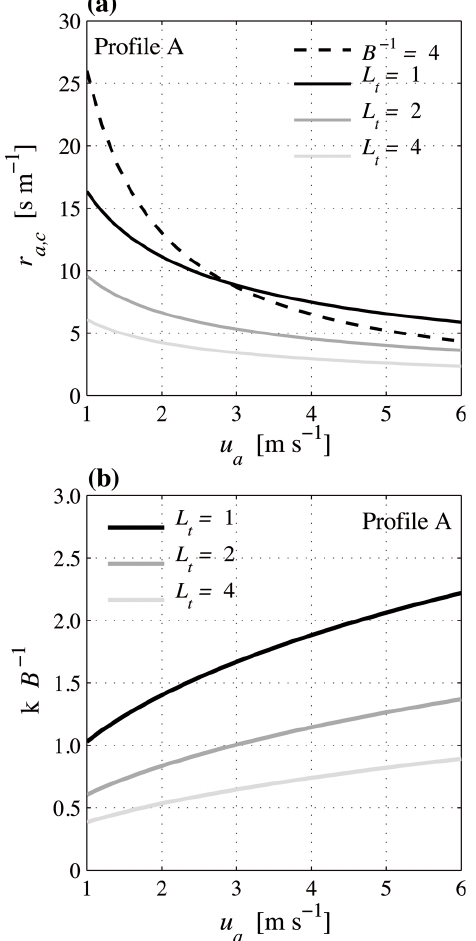
Fig. 5. (a) The additional aerodynamic resistance ( r a,c ) given by Eq. (20) is plotted as a function of wind speed at reference height ( u a ) for different LAI ( L t ) and compared with the rough estimate based on B − 1 = 4 (leaf area profile A); (b) the bulk parameter kB − 1 (inferred from the value of r a,c ) is plotted as a function of wind speed ( u a ) for different LAI ( L t ) and the same profile of